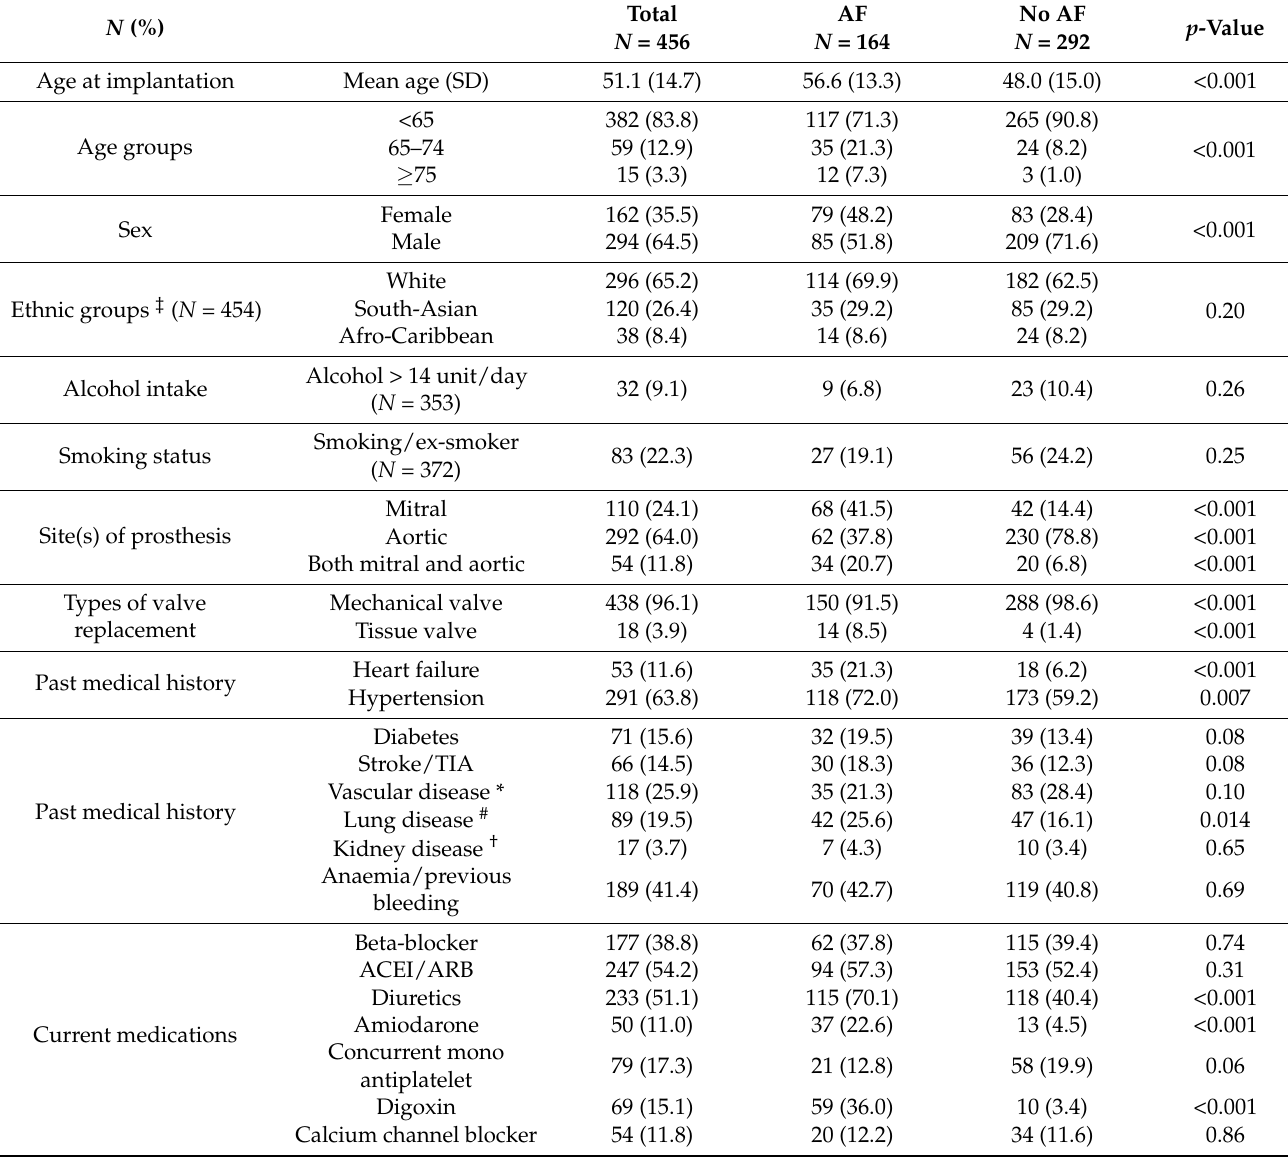
Table 1. Baseline characteristics of patients with operated valvular heart disease, with and without